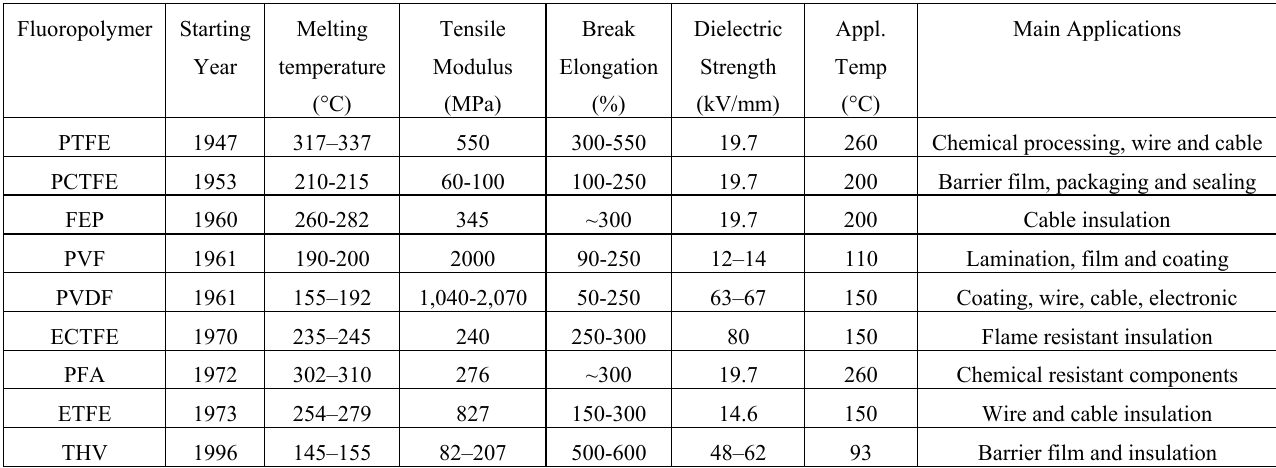
Table 2 . The summary of fluoropolymers with their general